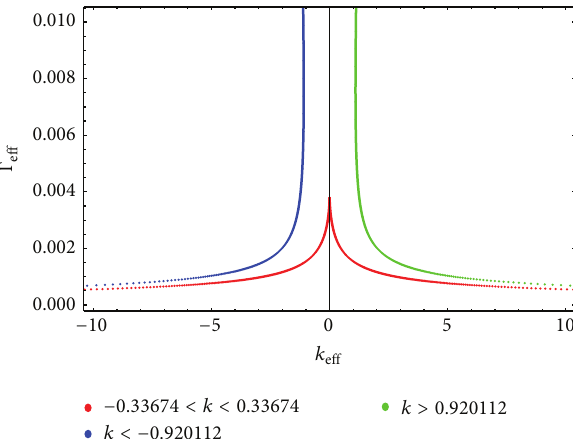
Figure 3: Effective frequency of the oscillon (bottom line) and its phantom (top line) for 𝑡 = 0 , 𝜆 = 10 −5 , 𝜖 = 0.01 , 𝑎 = 1.2 , and 𝑏 = 0.01